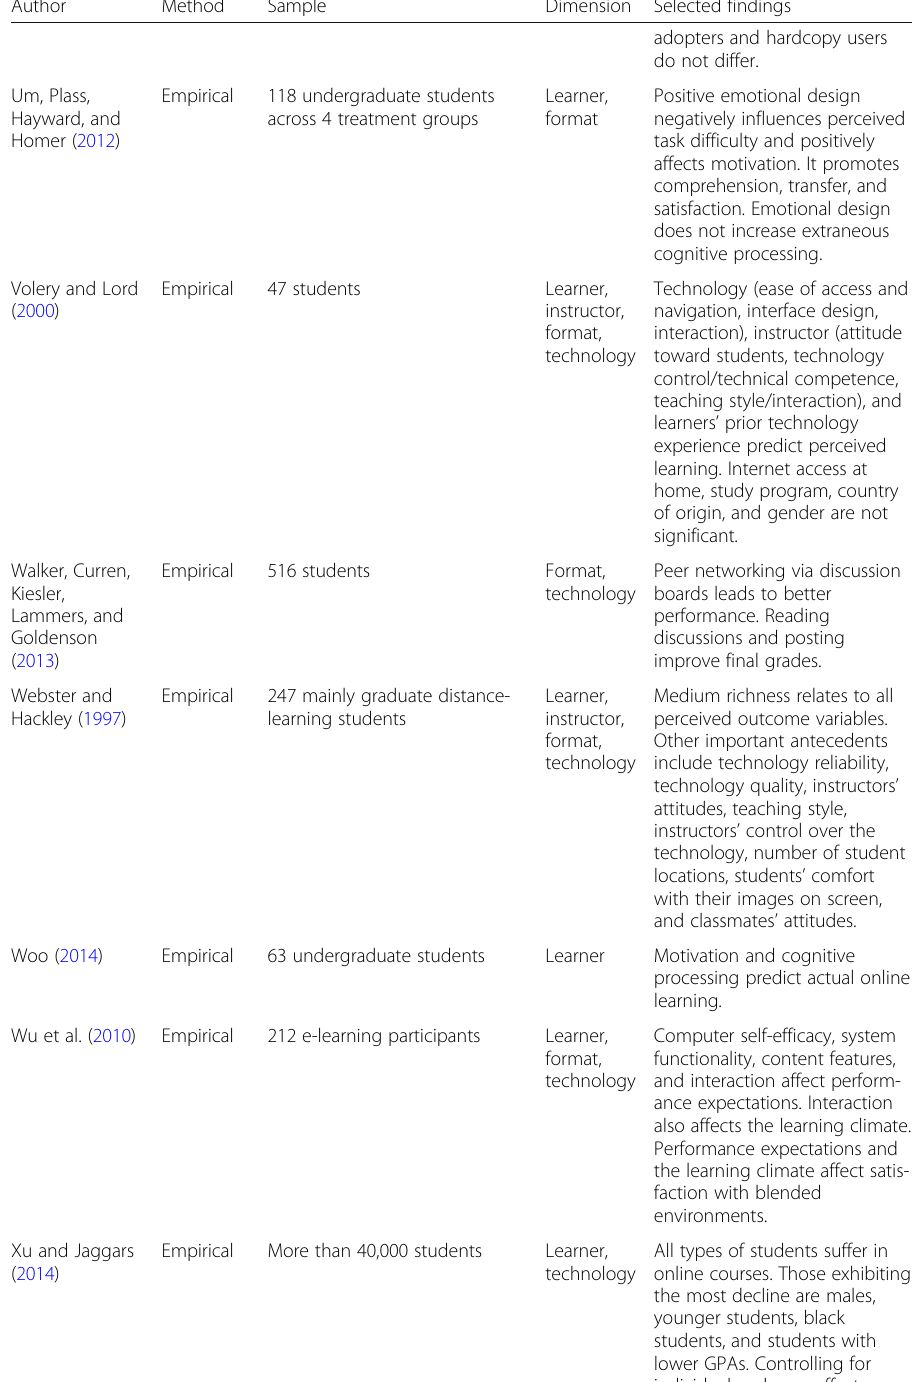
Table 1 Overview of Findings from the Extant Literature